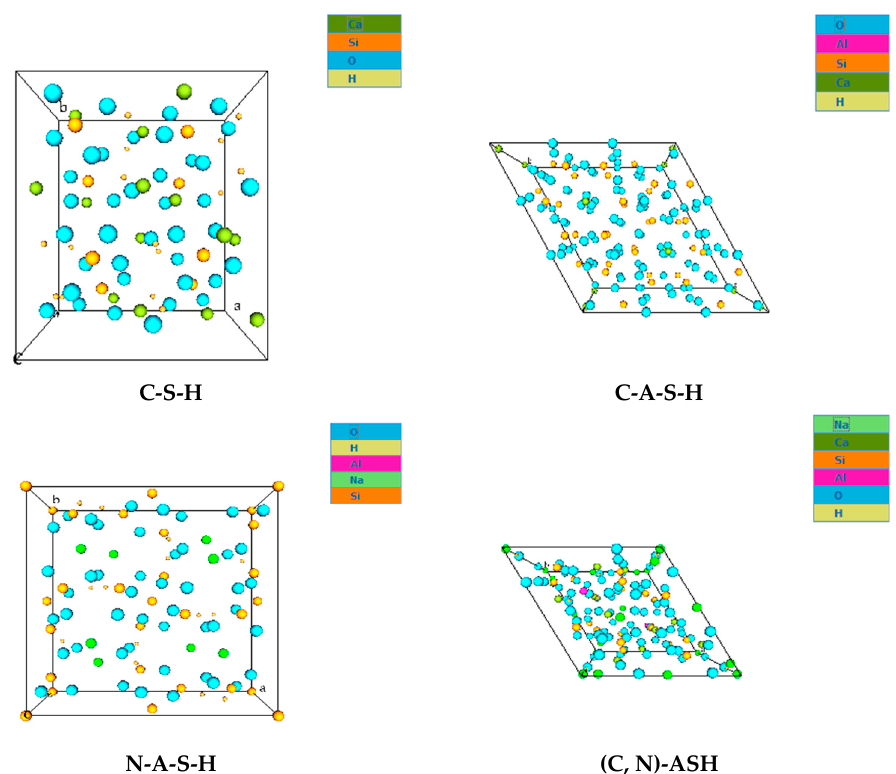
Figure 19. Molecular structure of C-S-H, C-A-S-H, N-A-S-H, and C, N-ASH.